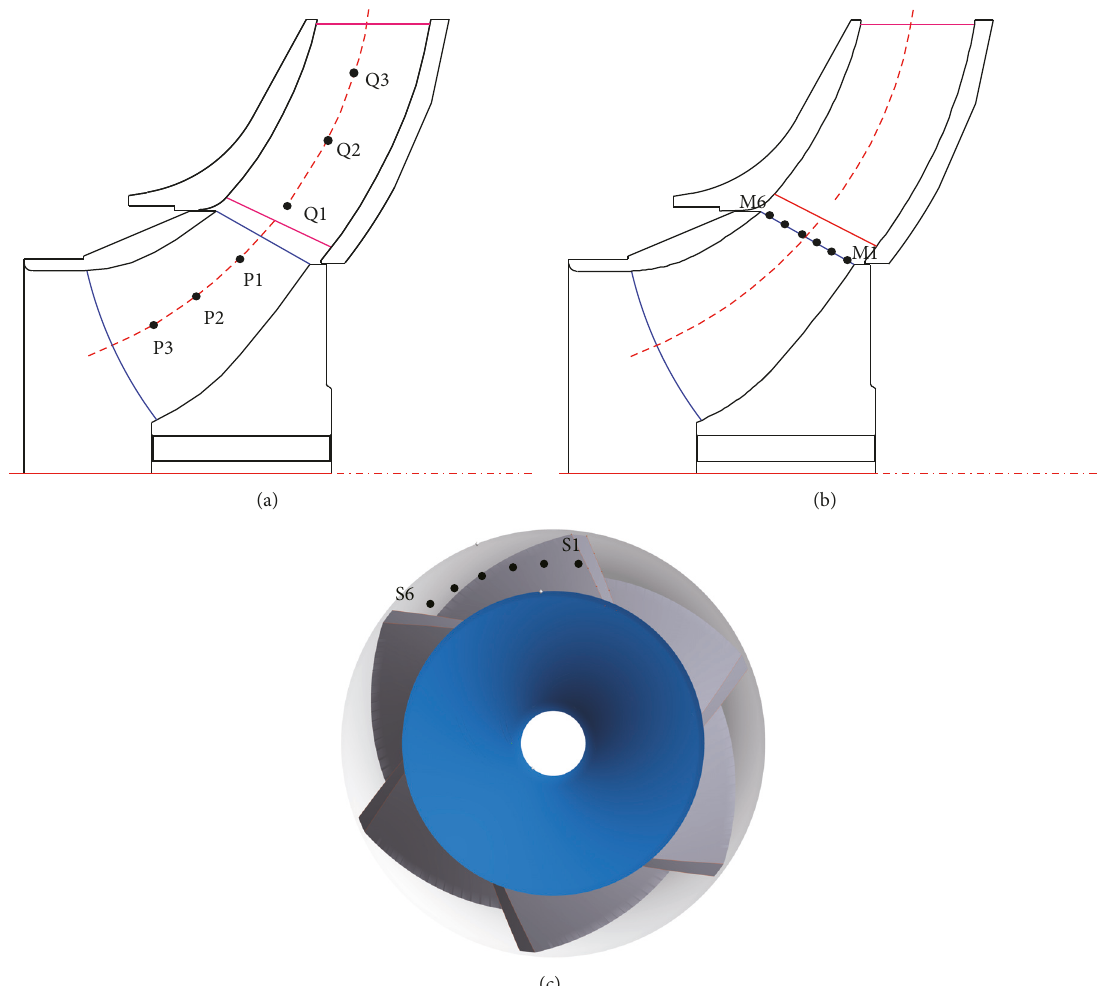
Figure 6: Monitoring points